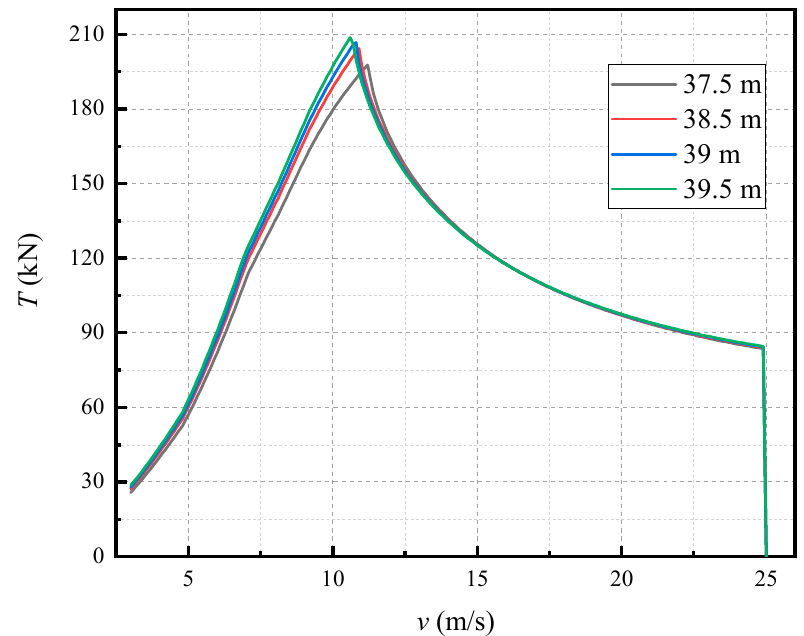
Figure 7. Thrust of the wind rotor for turbines with different blade lengths.